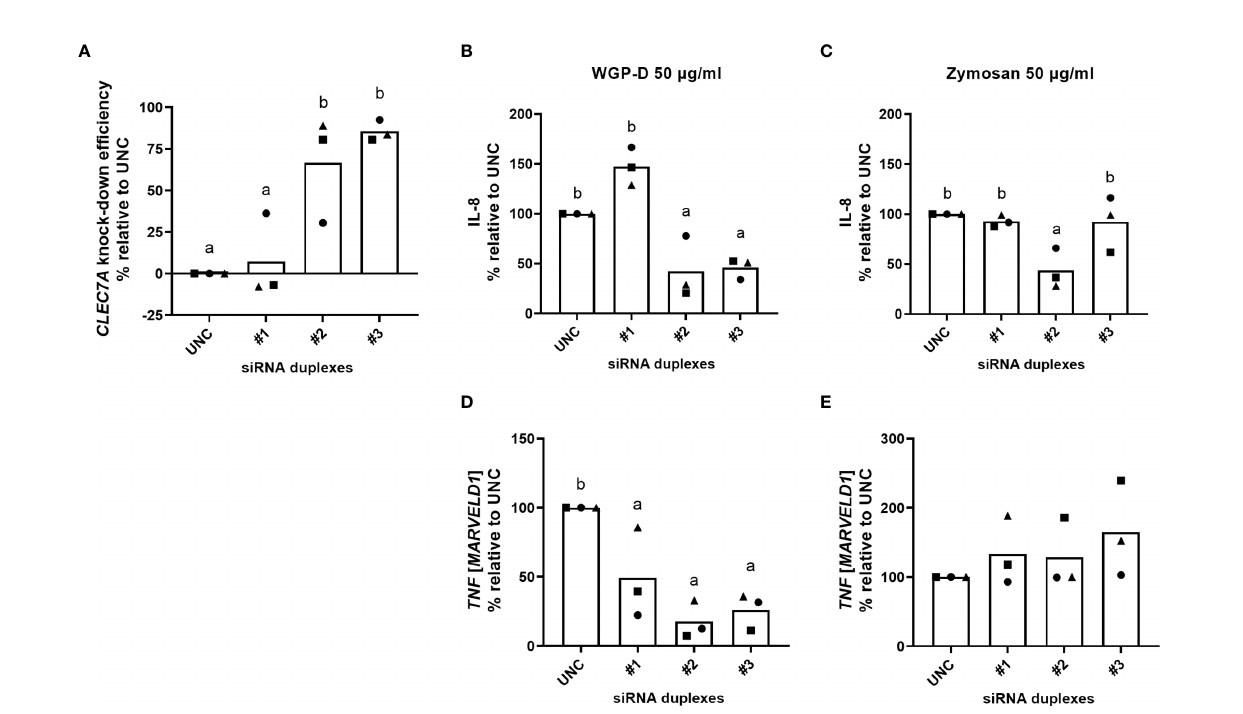
FIGURE 5 | Bovine CLEC7A knockdown ef fi ciency (A) , calculated relative to MISSION ® siRNA Universal Negative Control #1 (UNC) treated cells. Cells were cultured with RPMI-1640 after transfection procedure with three different siRNA duplexes (#1, #2 and #3). IL-8 production (B, C) and TNF expression (D, E) of cells transfected with duplexes #1, #2 and #3 and MISSION ® siRNA Universal Negative Control #1 (UNC) and stimulated with WGP-Dispersible (B, D) or Zymosan (C, E) at 50 µg/mL, calculated in percentual change relative to UNC transfected cells. Results correspond to means from three different animals (each one represented by squares, triangles or circles). a,b Means with different superscript letters are signi fi cantly different ( P